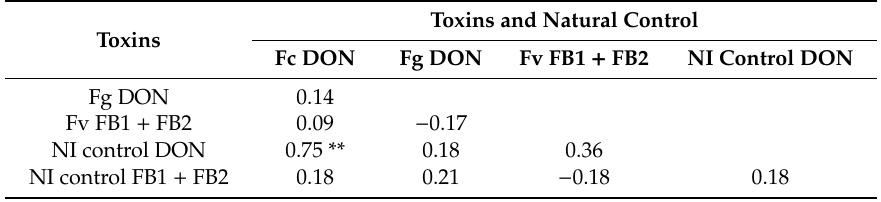
Table 13. Toxin contamination in KR resistance test, ( n = 10), 2010–2012, correlations between di ff erent toxins, data from Table 12.